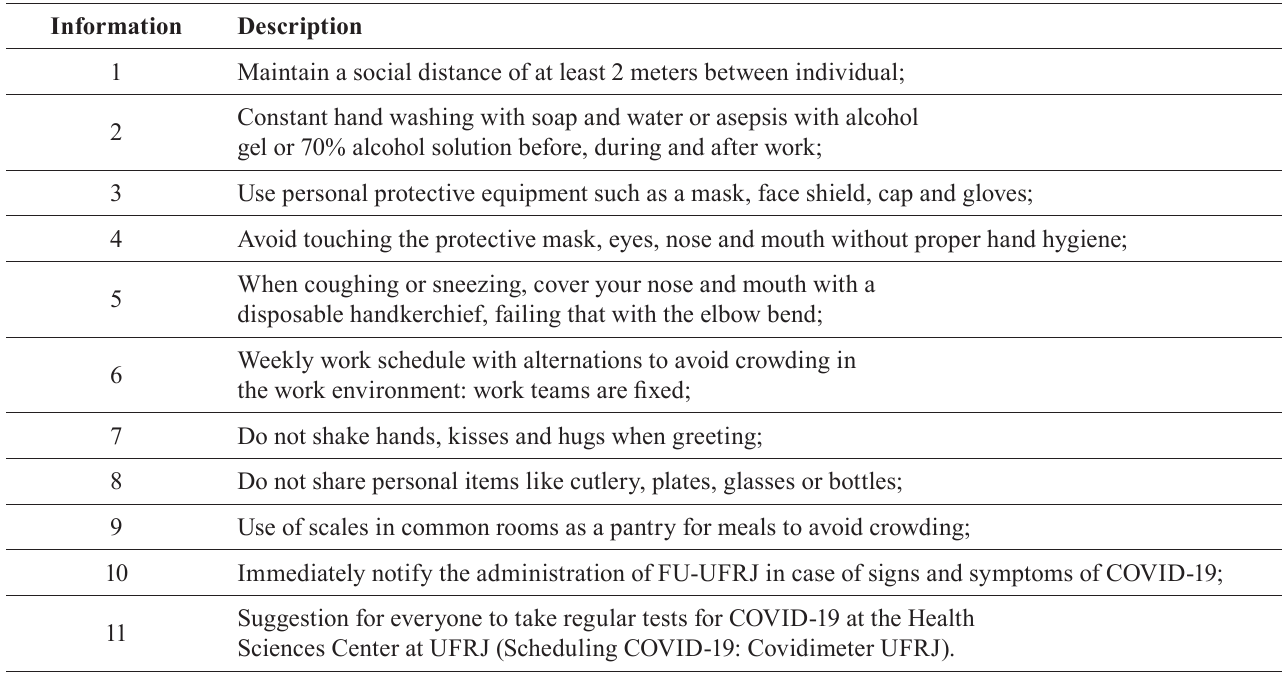
TABLE I - M ain points discussed in training with work team to minimize the risk of spreading the COVD-19 virus